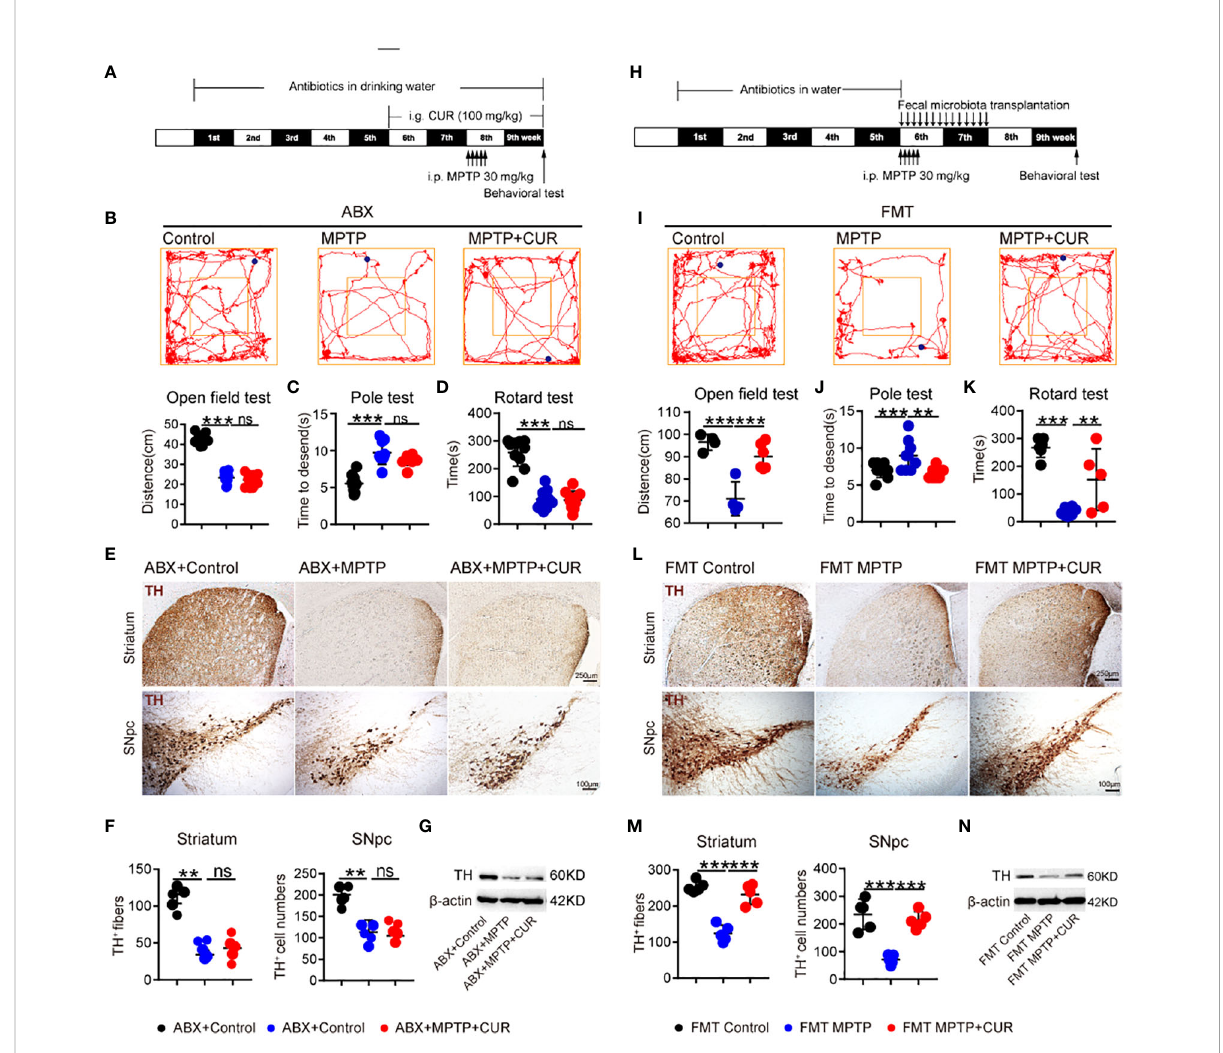
FIGURE 4 Antibiotic pretreatment (ABX) and fecal microbiota transplantation (FMT) validated that the gut microbiota mediated the neuroprotective effect of CUR in the MPTP-induced mice model. For the ABX treatment experiment, male C57BL/6 mice were received intragastric administration of CUR (100 mg/kg) once a day for 4 weeks starting from day 36. On day 50, mice were treated with 200 m L saline containing MPTP (30 mg/kg) or 200 m L saline via intraperitoneal injection every day for a total of 5 times to establish PD mice model. Mice were received water containing antibiotic solution or regular drinking water alone from the beginning to the end. For the FMT experiment, mice were received water containing antibiotic solution or regular drinking water alone from day1 to day 35. On day 36, FMT administration was performed once a day for 2 weeks. On day 63, behavioral tests were performed to evaluate the motor function and the mice were sacri fi ced to determine the pathology of mice by immunohistochemistry and immunoblot. (A) The experimental design for ABX treatment and 100 mg/kg CUR administration in MPTP-induced PD mice. (B) Representative traces and quanti fi cation of the open fi eld test among ABX MPTP treated mice, ABX MPTP+CUR treated mice and ABX controls (n = 10). Bluepoint: starting position; Redpoint: ending position. (C, D) Quanti fi cation of performance in the pole test and the rotarod test among 3 groups (n = 10). (E) Representative immunohistochemistry images of TH-positive fi bers and neurons in the striatum and SNpc among ABX MPTP treated mice, ABX MPTP+CUR treated mice and ABX controls. (F) Quanti fi cation of TH-positive fi bers and neurons in the striatum and SN (n = 6). (G) Representative bands of TH protein in striatum of one hemisphere determined by WB among 3 groups (n = 3). (H) The experimental design for FMT experiment. (I) Representative traces and quanti fi cation of the open fi eld test among FMT MPTP treated mice, FMT MPTP+CUR treated mice and FMT controls. Bluepoint: starting position; redpoint: ending position. (J, K) Quanti fi cation of performance in the pole test and the rotarod test among 3 groups (n = 6). (L) Representative immunohistochemistry images of TH-positive fi bers and neurons in the striatum and SNpc among FMT MPTP treated mice, FMT MPTP+CUR treated mice and FMT controls. (M) Quanti fi cation of TH-positive fi bers and neurons in the striatum and SN (n = 6). (N) Representative bands of TH protein in striatum of one hemisphere determined by WB among 3 groups (n = 3). Data are expressed as mean ± SEM and representative results are one of the independent experiments. All statistical differences were tested using one-way ANOVA in (B – D, F, I, J, K, M) . Quanti fi cation of TH-positive fi bers and neurons was performed by ImageJ. ** p < 0.01, *** p < 0.001, n.s., not signi fi